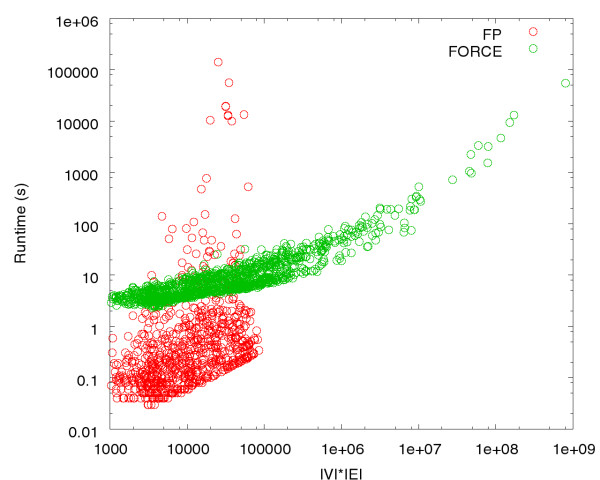
Comparison of the running times of FORCE against the exact fixed-parameter algorithm described in [2]. Plotted is the running time (y-axis in seconds) for different graph sizes (x-axis). Solely for visualization purposes, we describe the size of a graph on the x-axis as |V|·|E|. All graphs have been constructed from prokaryotic COG protein sequence comparisons using BeH as scoring function. Note that both axes are scaled logarithmically. The red points correspond to FORCE running times, and the blue points to the FP algorithm, respectively.